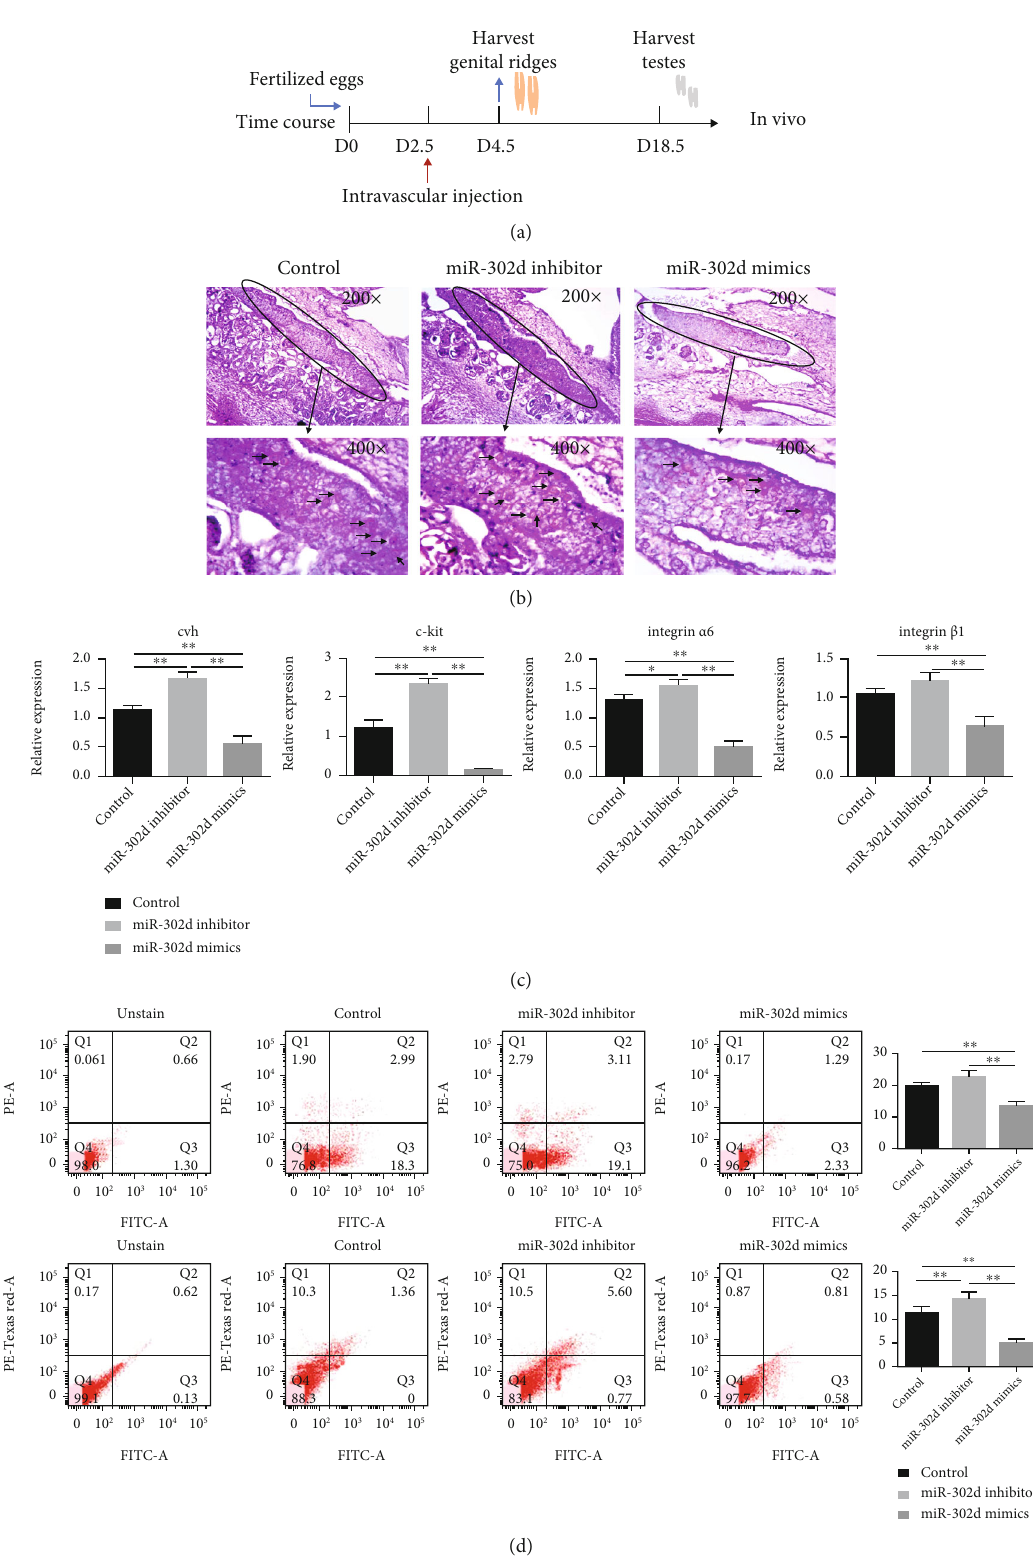
Figure 4: miR-302d function veri fi cation in vivo. (a) Experimental scheme in vivo. (b) PAS staining of day 4.5 embryos, in the oval is the genital ridge; ↑ the arrows point to PGCs. (c) Marker genes were detected on day 4.5 genital ridge and day 18.5 testes. (d) Flow cytometry analysis on day 4.5 genital ridge and day 18.5 testes and quanti fi cation of positive